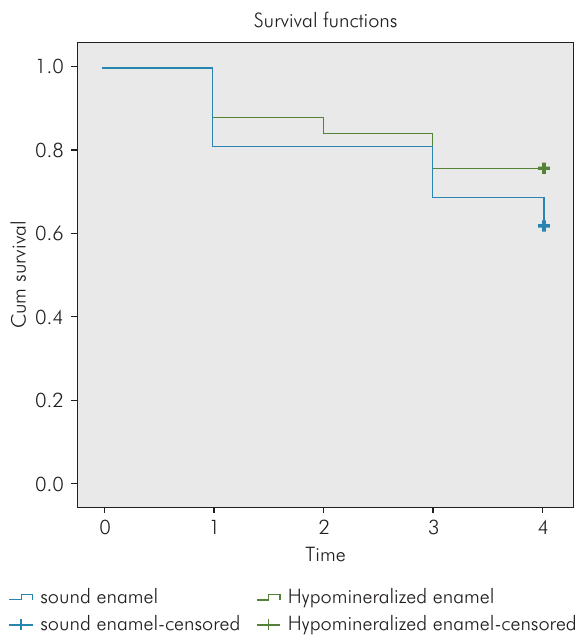
Figure 3. Sealant survival over time (Kaplan-Meier